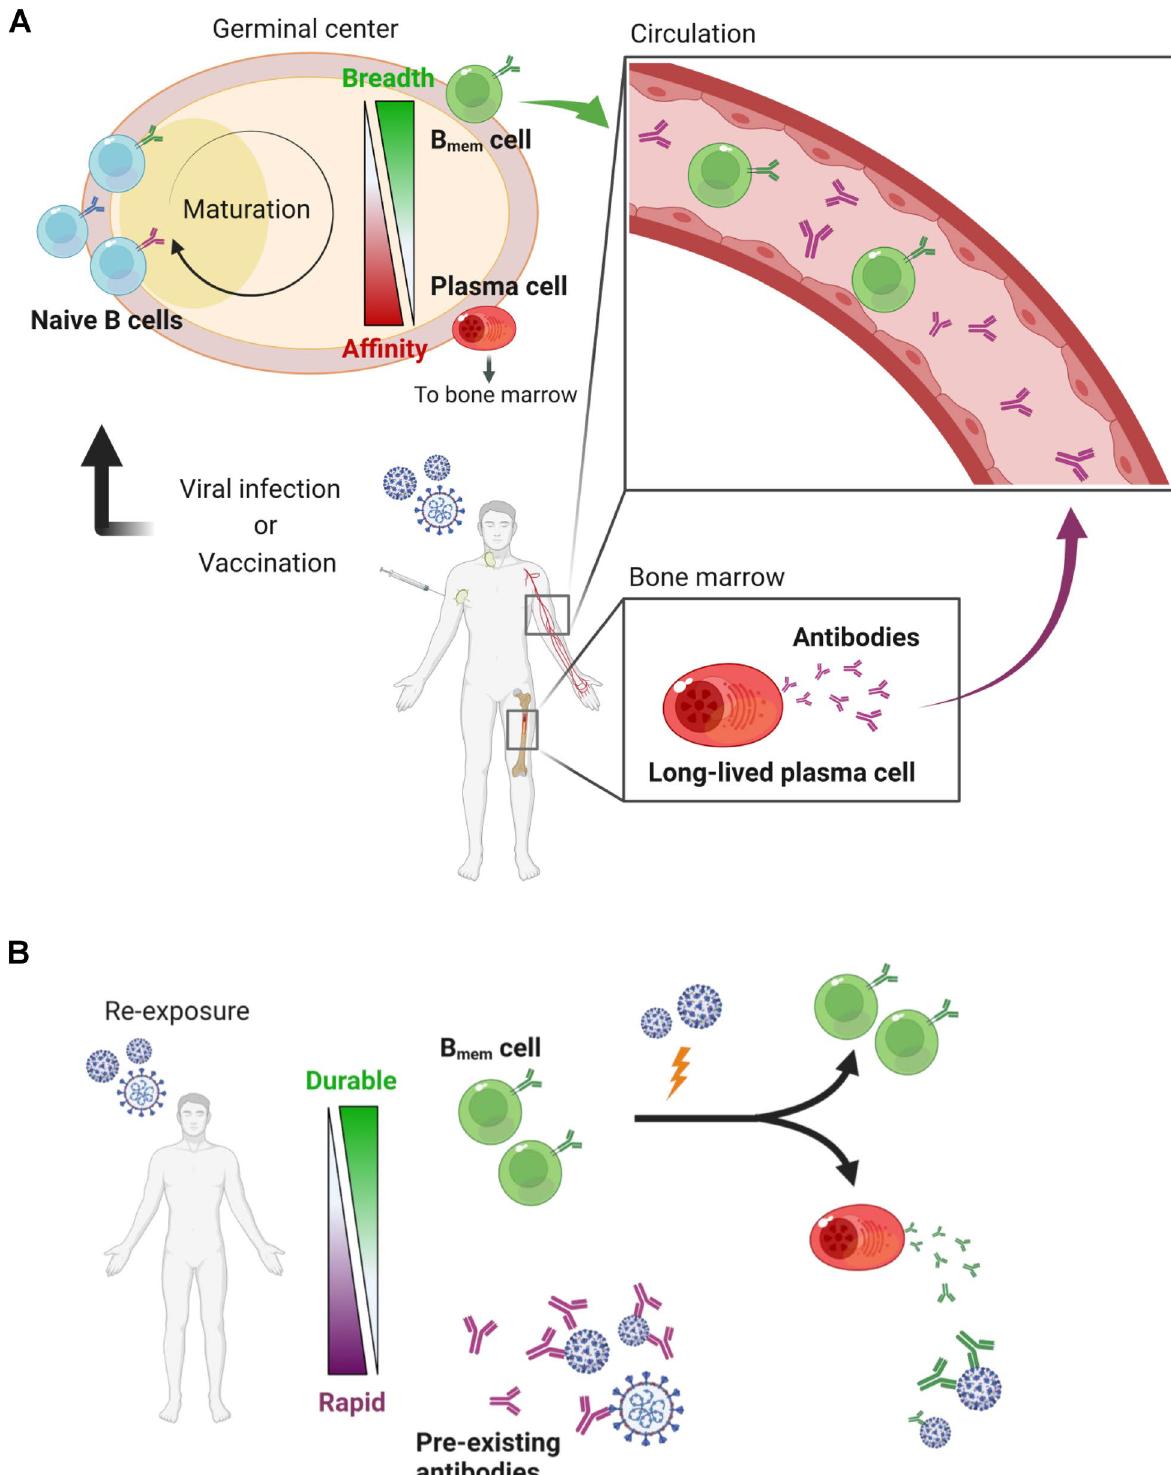
Fig. 1 Humoral immune memory responses. A Humoral immune responses to a primary antigen exposure are depicted. Viral infection or vaccination induces B mem and plasma cells through germinal center reaction, conferring immunological memory. B Memory responses to antigen re-exposure are described. Pre-existing antibodies secreted from long-lived plasma cells rapidly eliminate the viruses, whereas B mem cells function as a backup reservoir for plasma cells. The figure was created with